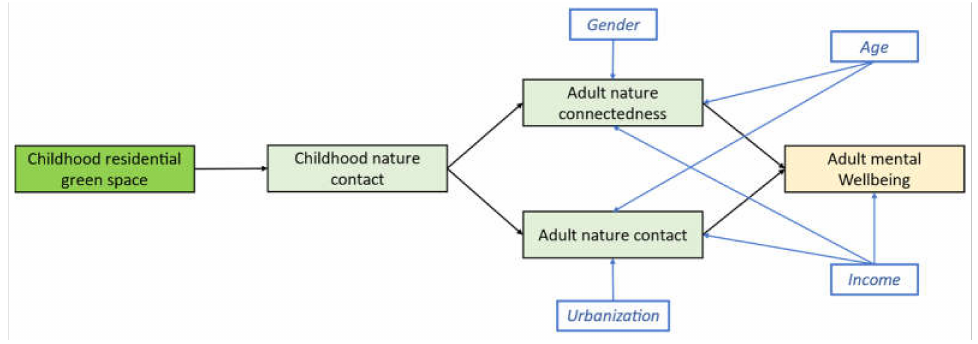
Figure 2. Initial model tested, including control